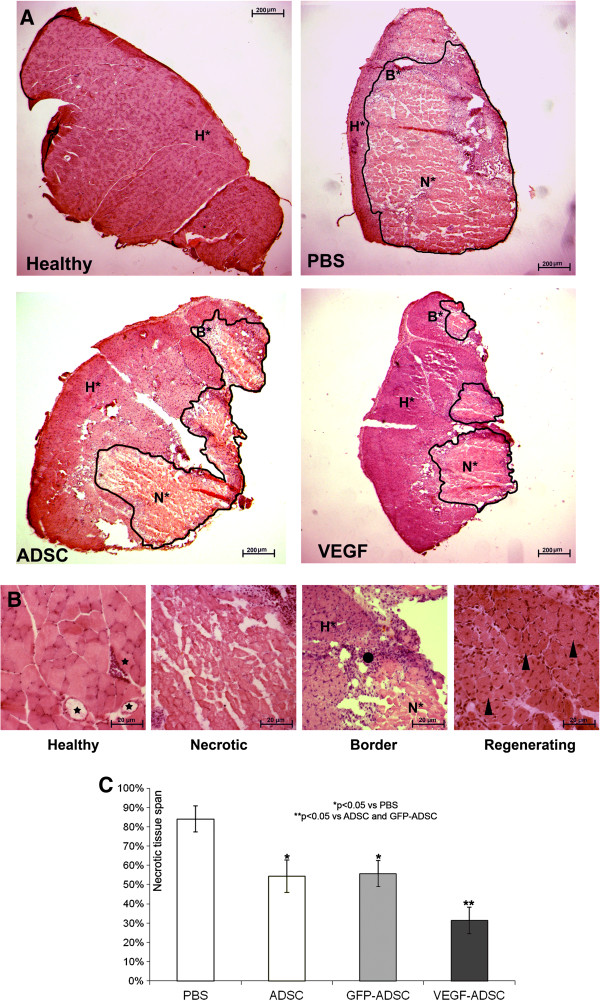
Morphometric analysis of tissue necrosis in ischemic muscle from study group animals. A. Images of hematoxylin-eosin stained m. tibialis anterior sections. Necrotic tissue is marked by black line. (N* - necrotic tissue, B* - border zone, H* - healthy or regenerating tissue). B. Representative images of muscle tissue from different zones of section. Labels: star – vasa in normal muscle tissue with; black dot – inflammatory demarcation zone between anucleic disrupted tissue and regenerating muscle fibers; triangle – regenerating round-shaped muscle fibers with multiple centrally located nuclei. C. Statistical data of necrotic tissue area in “PBS”, “ADSC”, “GFP-ADSC” and “VEGF-ADSC” groups. Measurements made in 4–5 animals per group.